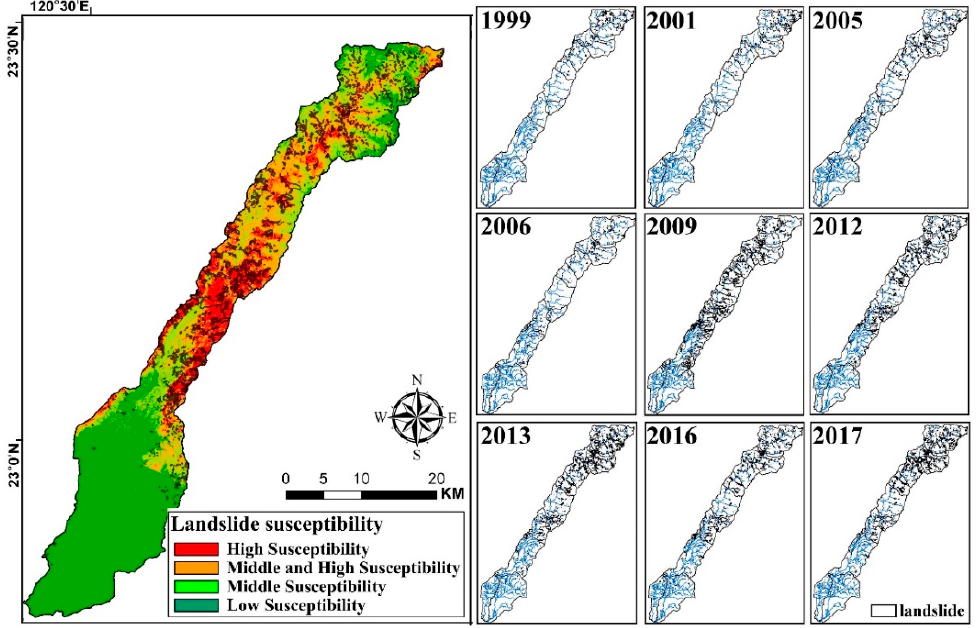
Figure 3. The landslide distribution during 1999–2017 ( right figures ) and the landslide susceptibility map ( left figure ) in the Chishan river watershed. map ( left figure ) in the Chishan river